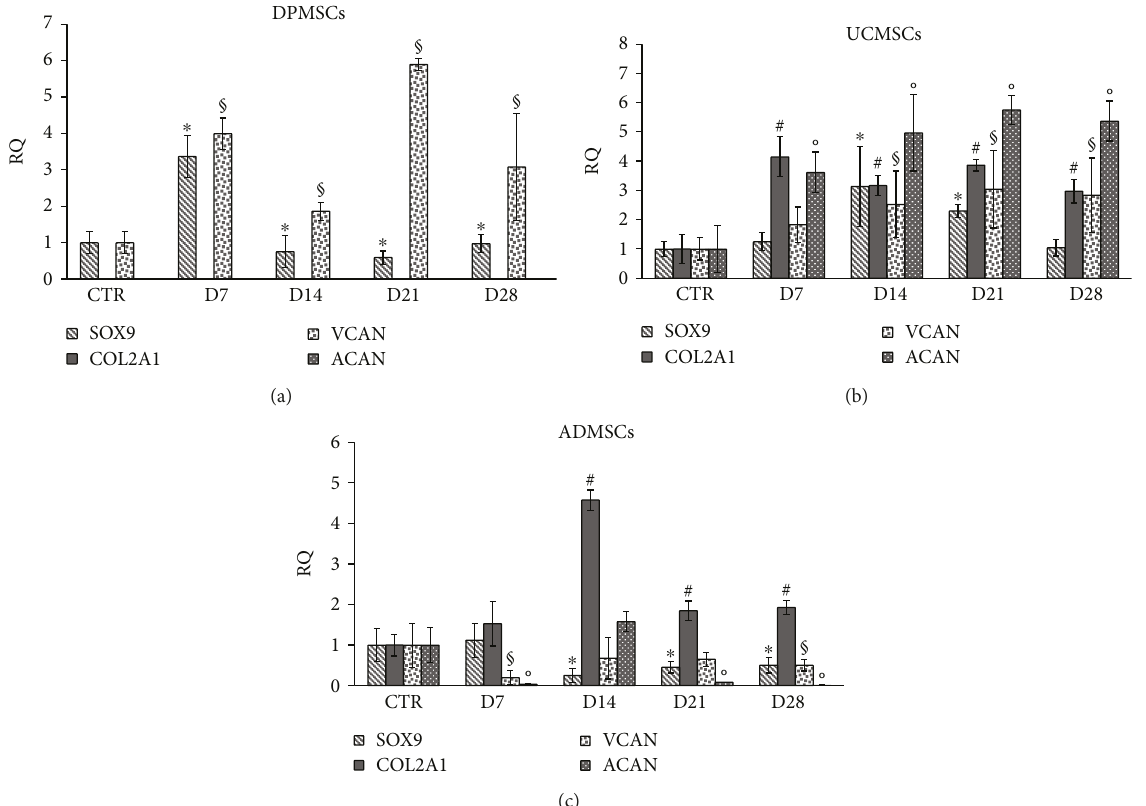
Figure 3: E ff ects of CoCl on the MSCs induced to chondrogenic phenotype for 7, 14, 21, and 28 days. mRNA expression of SOX9, COL2A1, 2 VCAN, and ACAN in (a) DPMSCs, (b) UCMSCs, and (c) ADMSCs. Gene expression was normalized to the corresponding GAPDH and calculated as relative expression compared to control cells for the DPMSCs and UCMSCs and to D14 for the ADMSCs. The experiments were performed three times. Data were expressed as mean ± SD. ∗ p < 0 05 , as compared to control SOX9 mRNA; # p < 0 05 , as compared to control COL2A1 mRNA; § p < 0 05 , as compared to control VCAN; ° p < 0 05 , as compared to control ACAN.